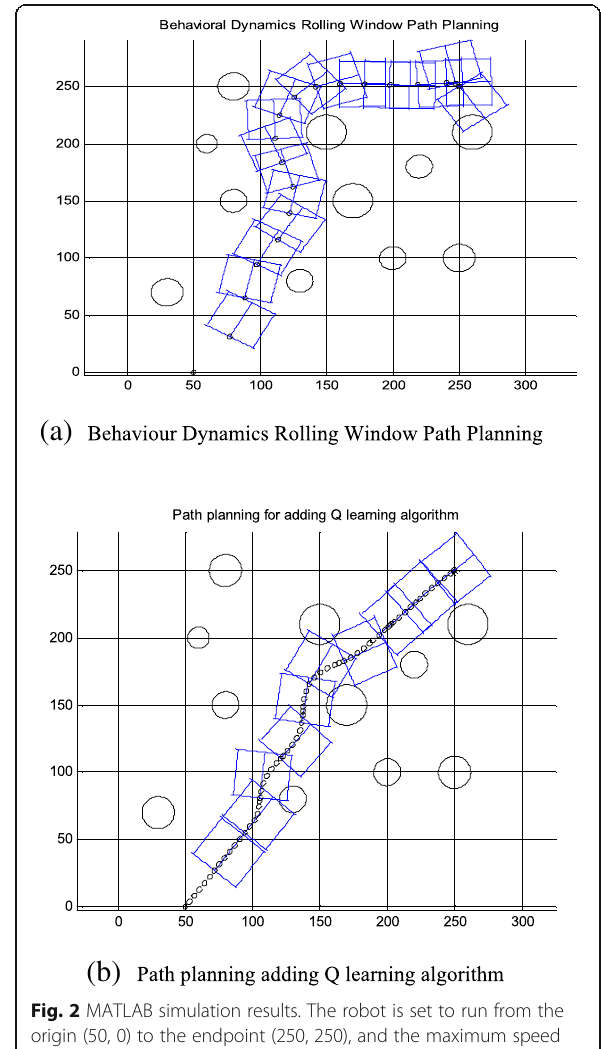
Fig. 2 MATLAB simulation results. The robot is set to run from the origin (50, 0) to the endpoint (250, 250), and the maximum speed does not exceed 2 m/s. There are multiple obstacles of different sizes in the environment. The size of the rectangular window is 40 × 34. In the scroll window, the small “ 。 ” indicates the position of the robot and forms the robot ’ s movement trajectory. a, b The same environment, in b robot can walk from small space to target point. This result show that Behavior Dynamics Rolling Window Path Planning adding Q learning algorithm is much suitable than